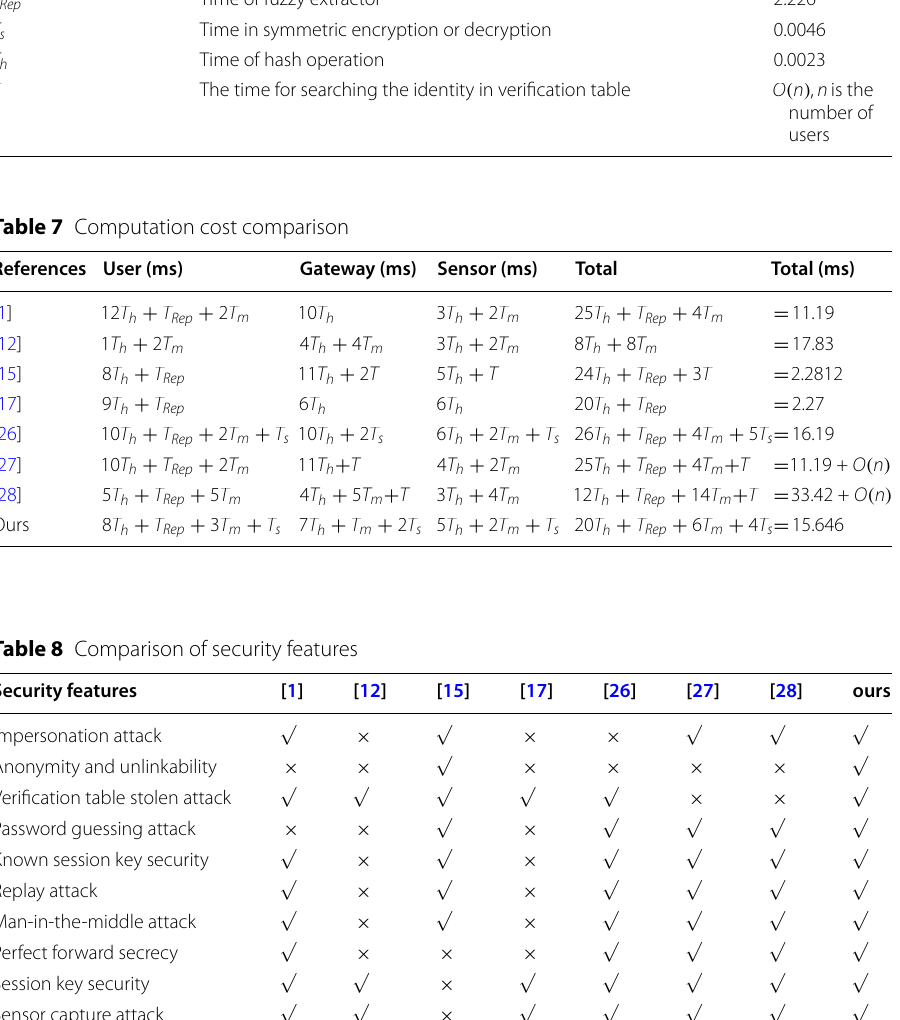
Verification table stolen